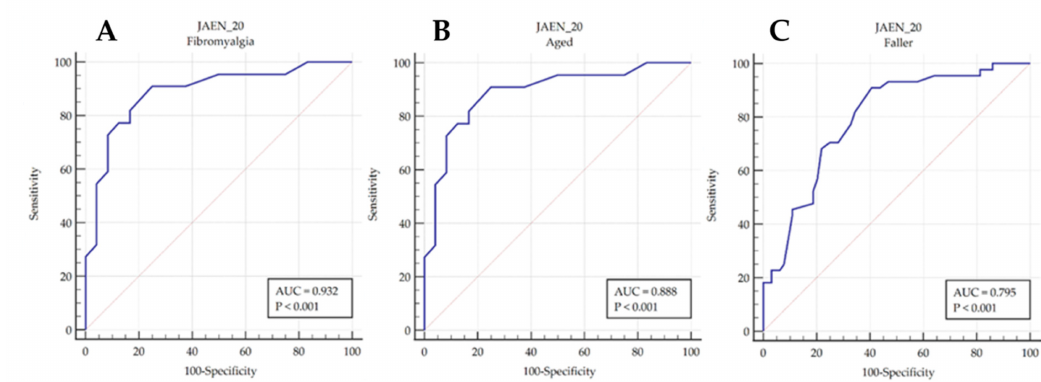
Figure 1. Receiver operating characteristic (ROC) curve to discriminate between fibromyalgia syndrome (FMS) patients and healthy controls ( A ), older adults and healthy controls ( B ), and fallers and non-fallers ( C ), in terms of balance disorders.